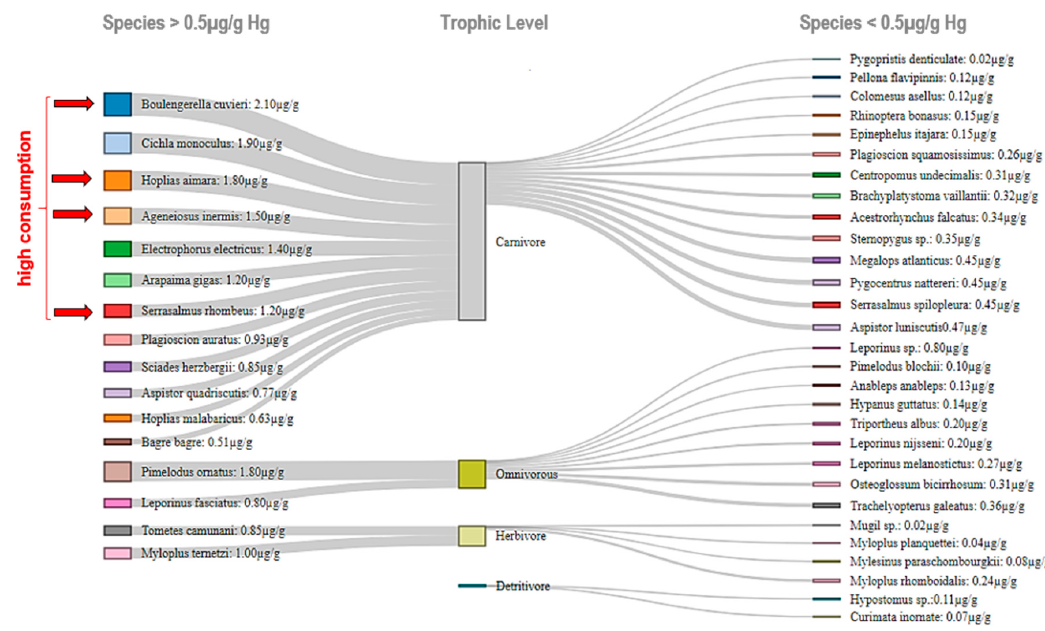
Figure 3. Sankey diagram categorizing the studied fish species and trophic levels by total mercury concentrations ( ≥ 0.5 µg/g and ≤ 0.5 µg/g).